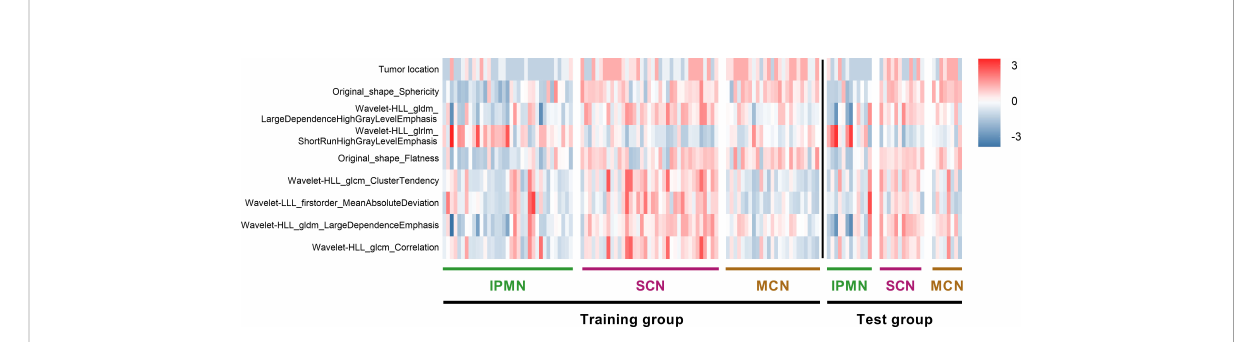
FIGURE 6 Heat map of radiomics features and cases in the three categories. The features on y-axis from top to bottom are arranged in a descending order according to the DXScore value. Right color bar represents color coding of normalized value of each radiomics